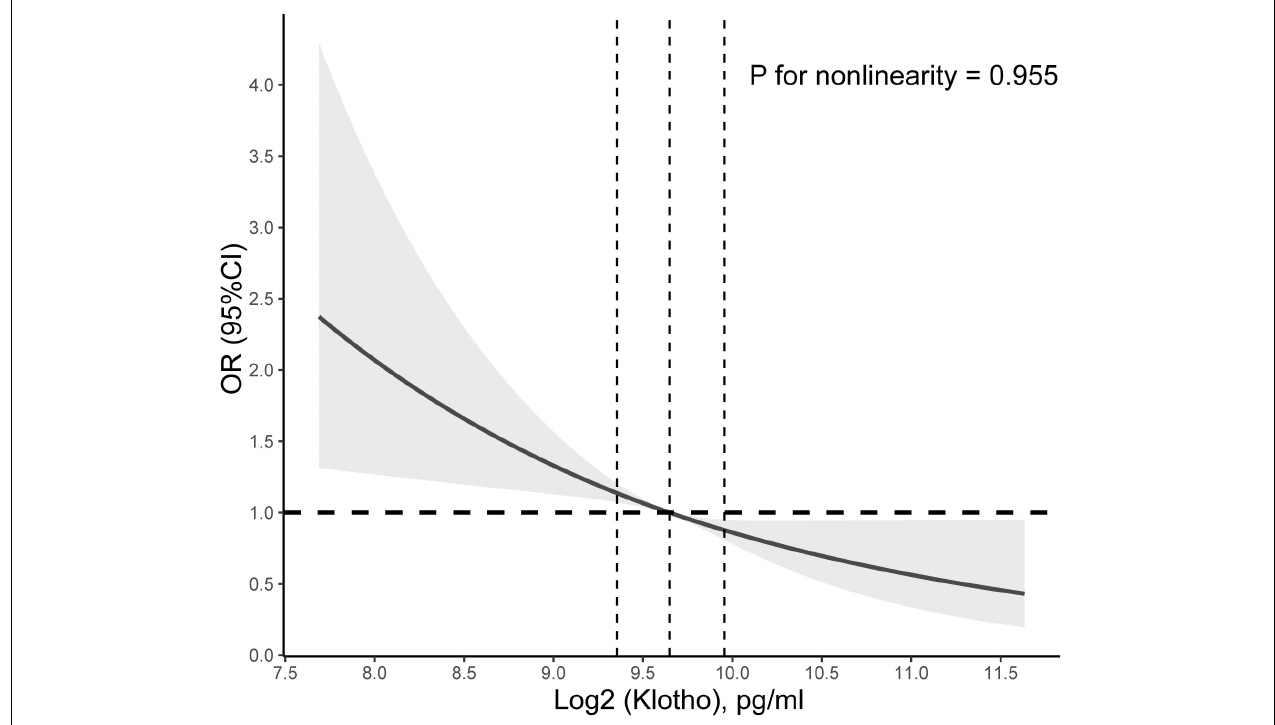
FIGURE 1 | Association between Klotho level and congestive heart failure (CHF). Adjusted odds ratio of CHF from a restricted cubic spline logistic regression model with knots at the 10, 50, and 90th percentiles. Adjusted for age, sex, education level, race, poverty, smoker, alcohol user, body mass index, sedentary time, high-density lipoprotein cholesterol, total cholesterol, urinary albumin, diabetes mellitus, and hypertension. The solid and dashed lines represent the odds ratios and corresponding 95% confidence intervals. Dashed vertical lines are plotted at each quartile of Klotho level.